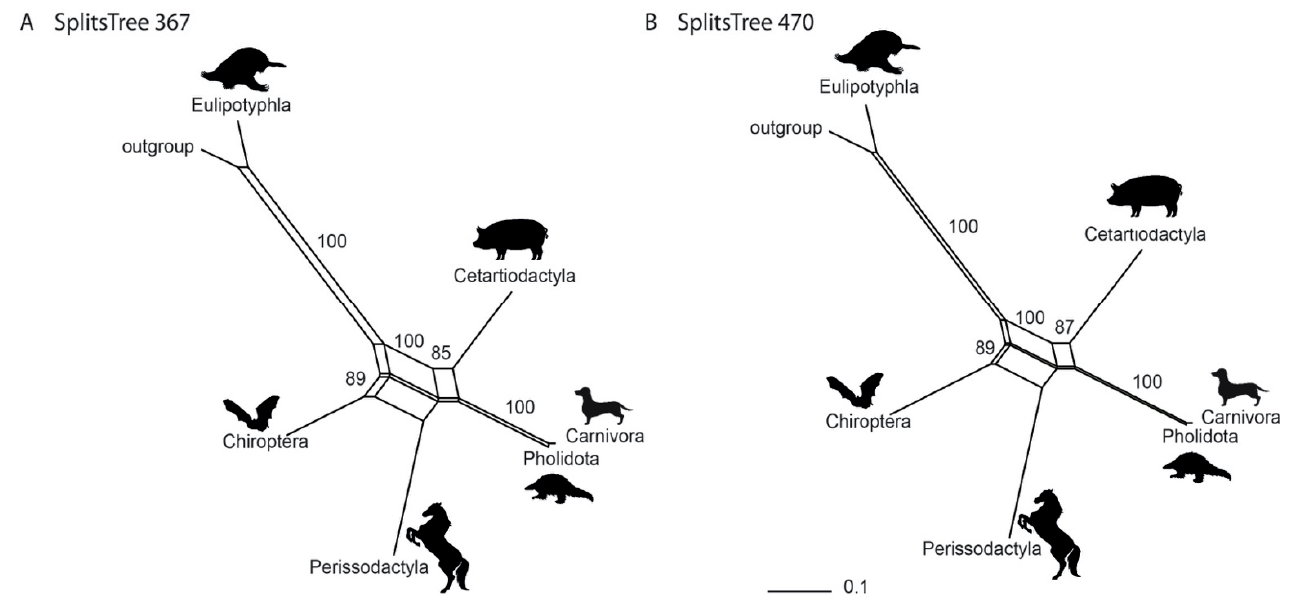
Figure 3. Phylogenetic networks from neighbor-net analyses (SplitsTree4). The datasets of ( A ) 367 and ( B ) 470 retrotransposon markers were analysed. Numbers represent bootstrap values. Branch lengths are indicated below the